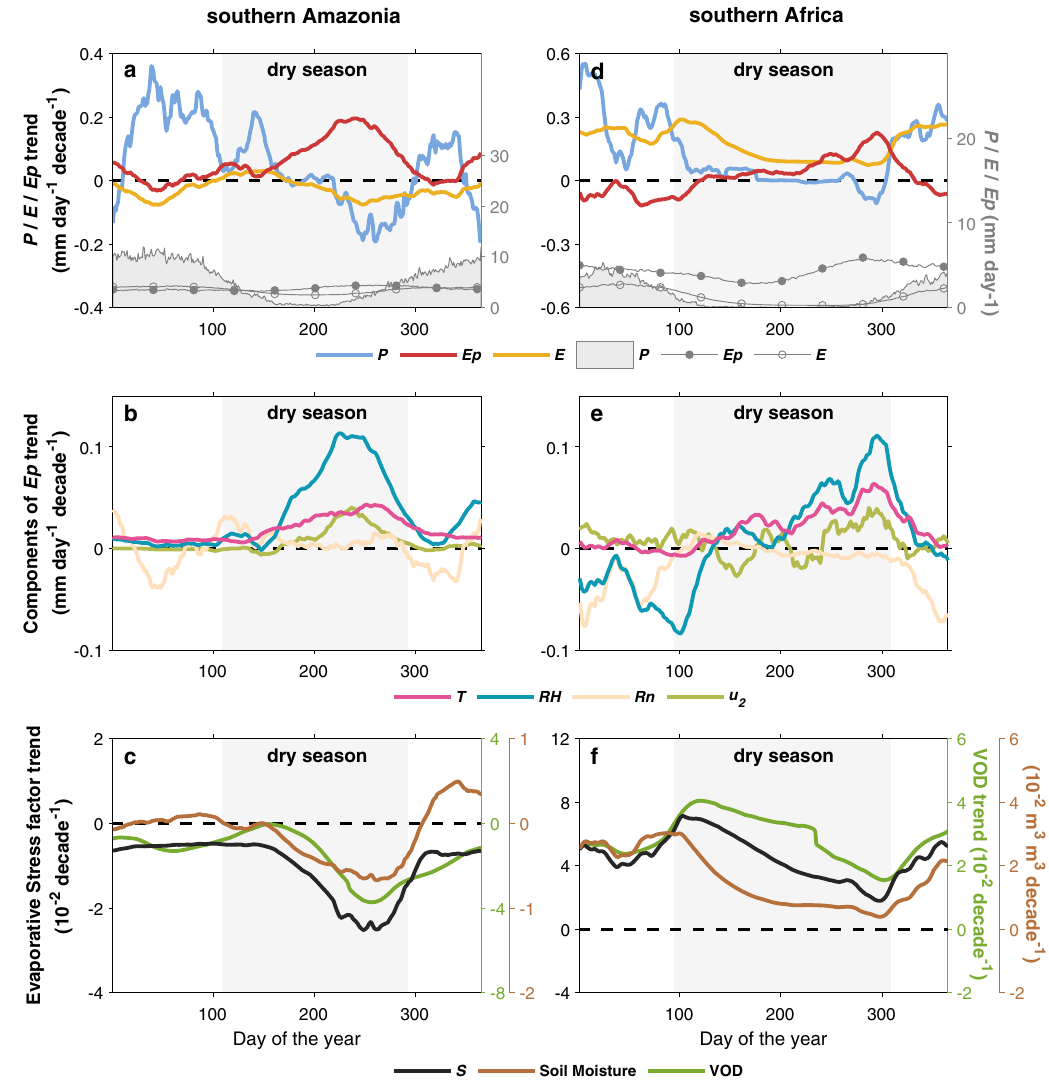
Fig. 5 Seasonal trajectories of P , Ep , E changes and the drivers in southern Amazonia and southern Africa. For each day of the year, the linear trends were calculated with the zonally averaged and 30-day smoothed daily values over southern Amazonia (48 – 65°W, 5 − 16°S, a – c ) and southern Africa (12- 30°E, 13-23.5°S, d – f ), over the 1983-2016 period. a , d These show the daily means and overall trends of P, Ep , and E . The gray area (in a and d ) indicates the dry season based on P < (cid:1) P . b , e They show the individual contributions of T , RH , u 2 , and Rn to the overall trend of Ep . c , f These show the changes of parameters ( S , VOD, S oil Moisture) representing the constraints of soil moisture and vegetation water content on E . Datasets included in this analysis are: P from MSWEP v2.8, Ep , T , RH , u Rn from ERA-5 . E , Stress factor and Soil Moisture from GLEAM v3.3a, Vegetation Optical Depth from VODCA Ku- 2 , and band (available only for 1987 –